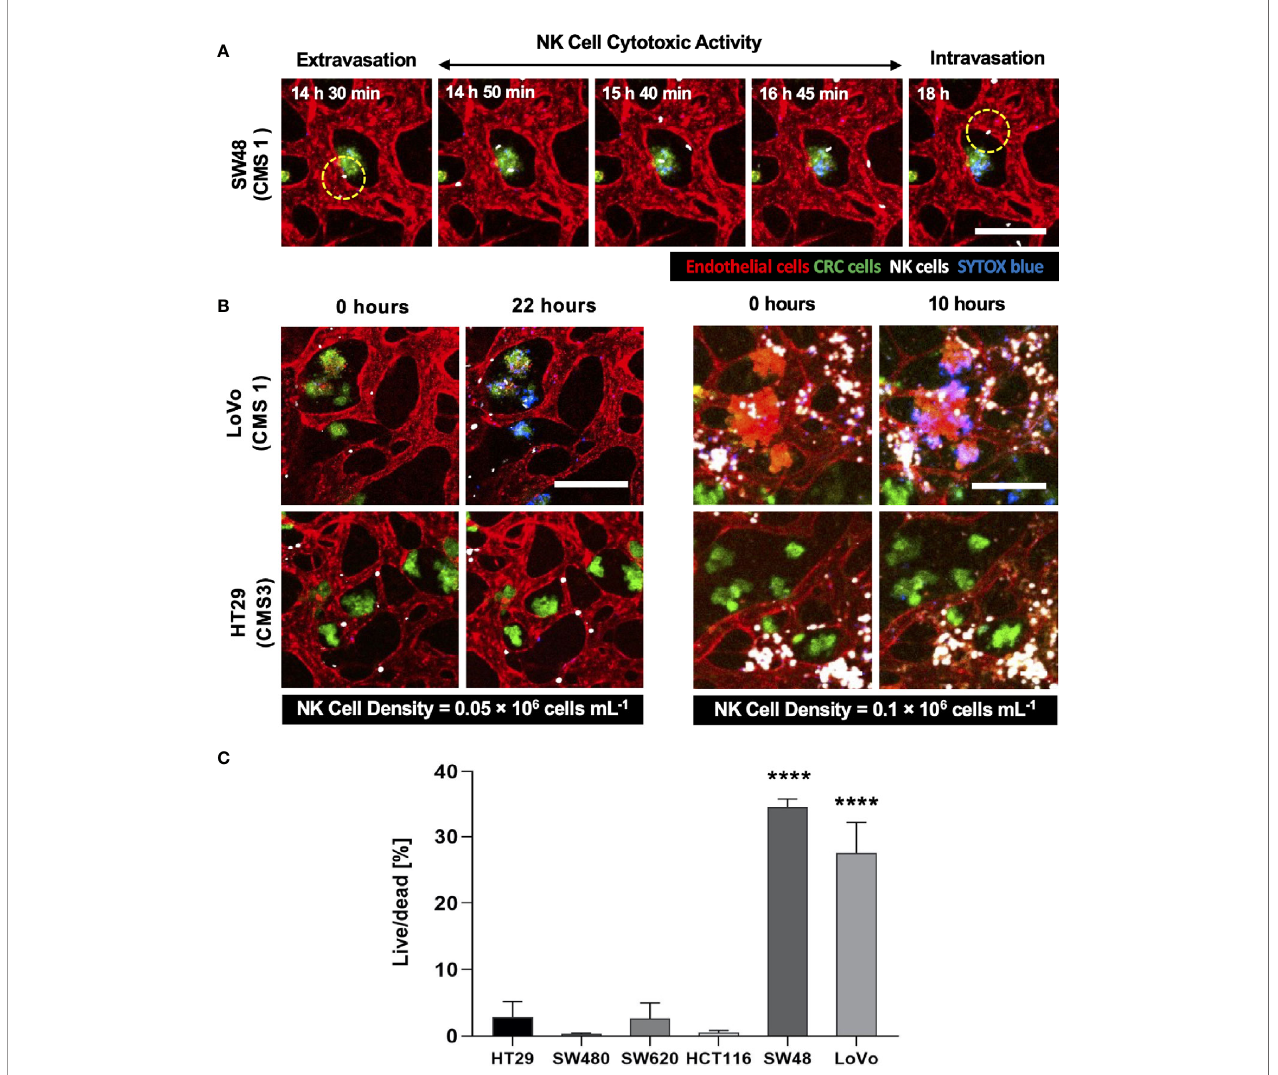
FIGURE 5 | 3D confocal images of NK cell cytotoxicity against CRC cells. (A) Time-lapse live-cell images of NK cell extravasation, migration, and their cytotoxic activity. Live-cell imaging was performed for 24 h. (B) Validation of NK cell cytotoxicity at relatively low and high concentrations of primary NK cells. NK cells (white) showed higher cytotoxic activity against LoVo (CMS1) compared to HT29 (CMS3). As the number of NK cells increased, more CRC cells were killed in a shorter period of time. (C) Live/dead assay on 6 different CRC cell lines. The result showed different cytotoxic effects of NK cells against CRC cells. See also Supplementary Videos S1 – S6 (n = 4 for each CRC cell line). ****p < 0.0001. Scale bar =